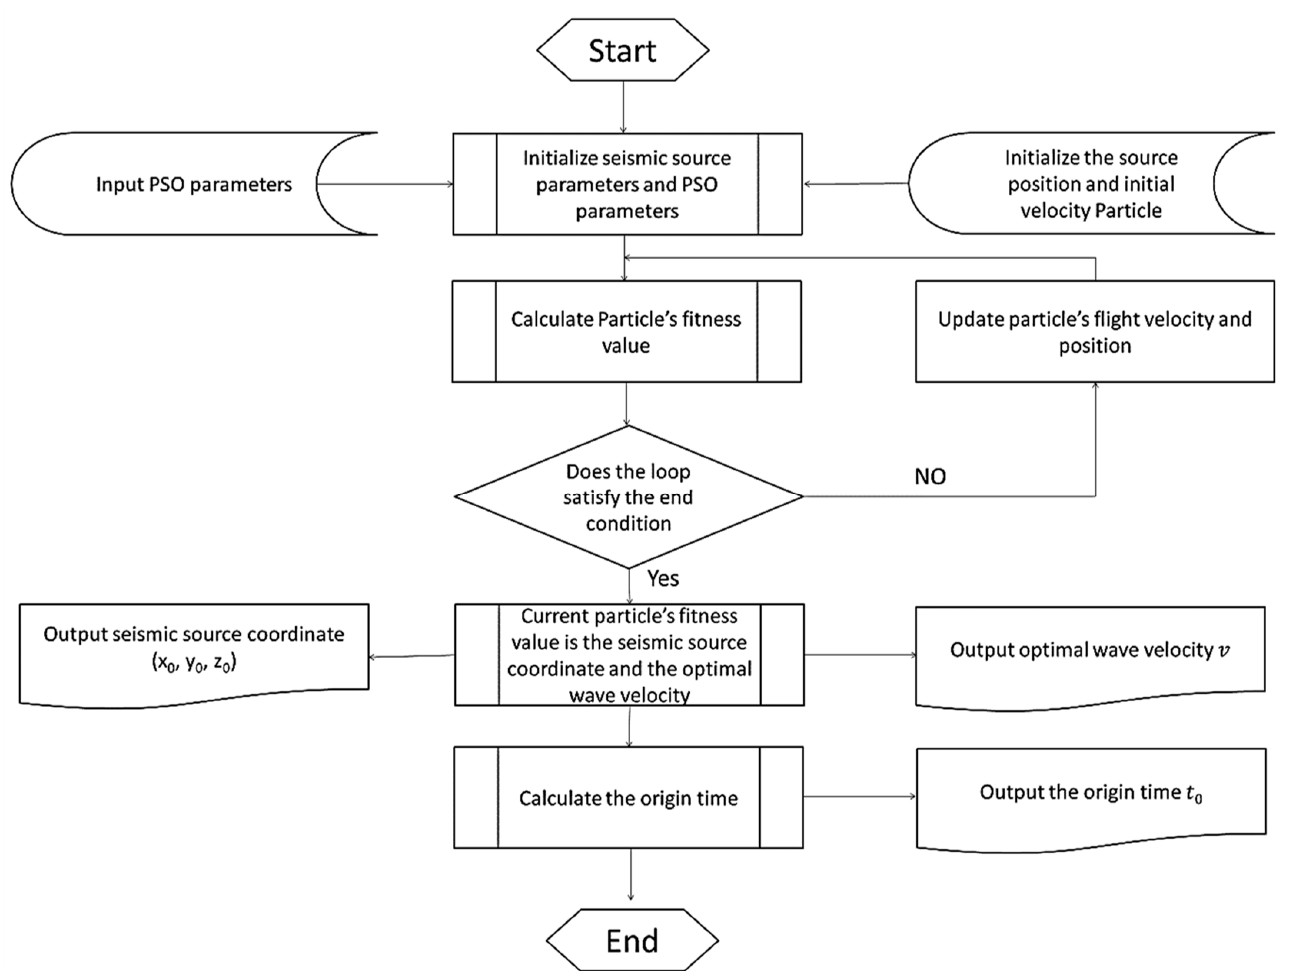
Figure 9. Procedure for the source location based on the PSO algorithm.